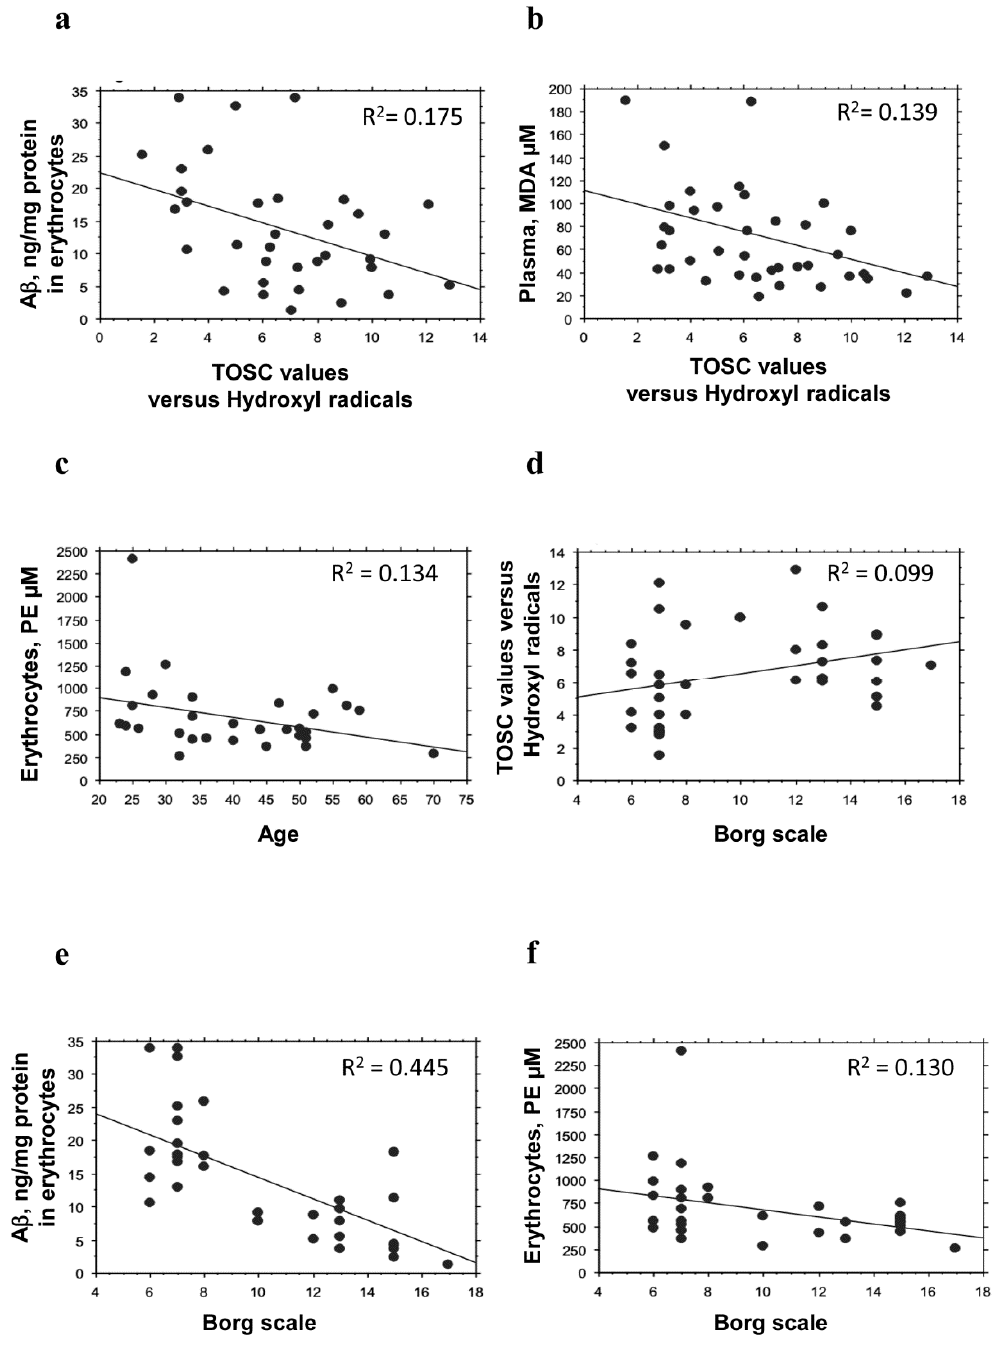
Figure 3. Correlation between plasma and erythrocytes well-being parameters. Correlation analysis between erythrocytes A β ( a ) or lipid peroxidation ( b ) and plasma AOC. ( c ) Correlation analysis between PE and age. Correlation analysis between plasma AOC ( d ), A β ( e ), or PE concentration ( f ) and Borg scale. Correlation between variables was determined by simple linear regression analysis, using the StatView program (Abacus Concepts, Inc., SAS Institute, Cary, NC). P and R 2 values obtained for each correlation are reported in the respective panel.